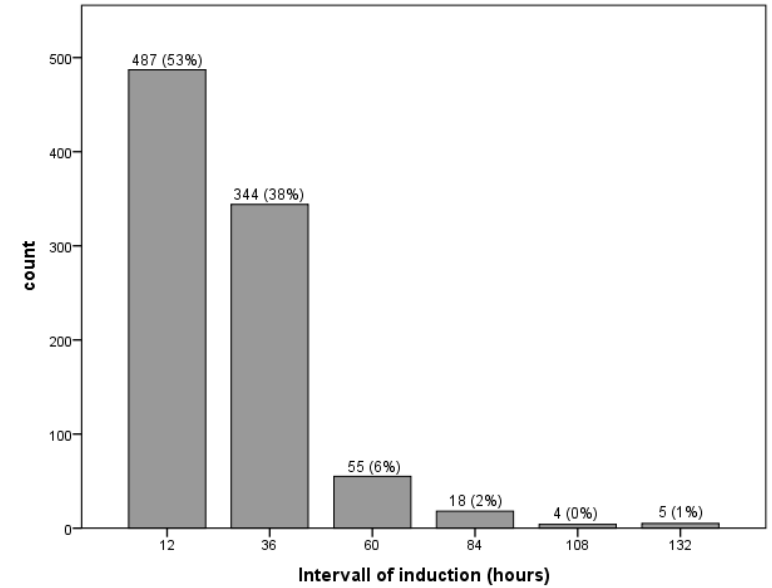
Figure 1. Interval between first induction and fetal expulsion.